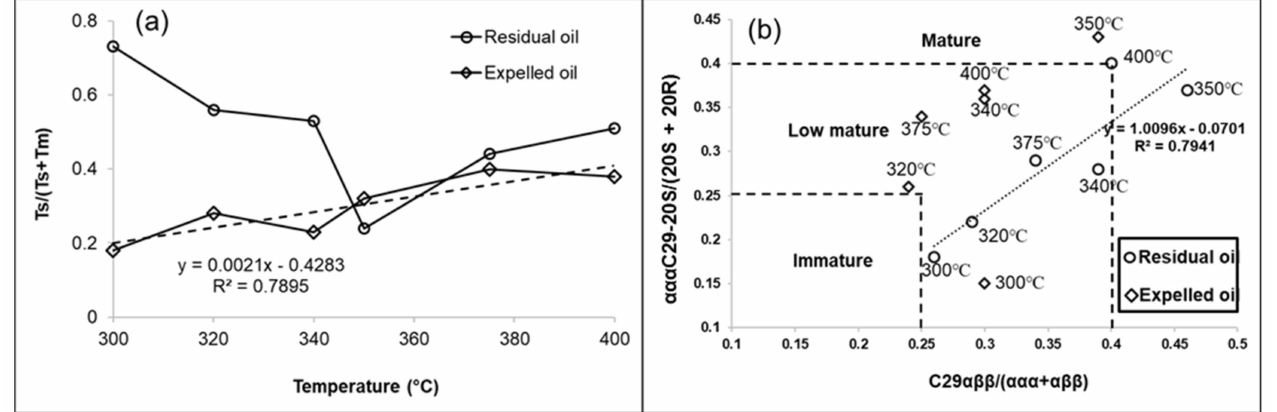
Figure 12. ( a ) Plots of Ts/ (Ts + Tm) vs. pyrolysis temperatures; ( b ) Variations in ααα C29-20S / (20S + 20R) vs. C29- αββ /( ααα + αββ ) for both residual oil and expelled